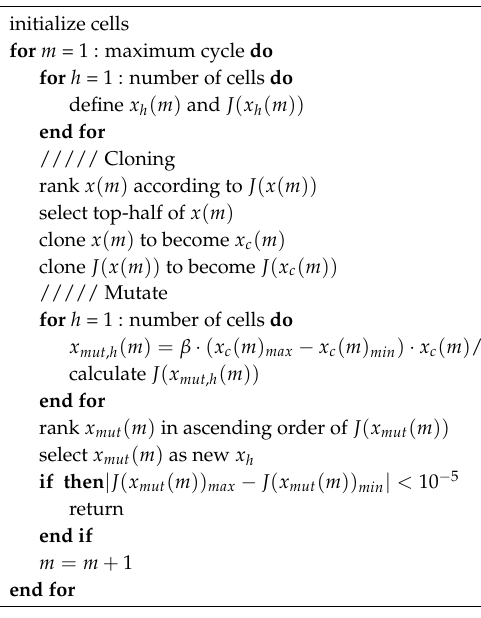
Algorithm 3 Pseudocode for the AIS algorithm [23].